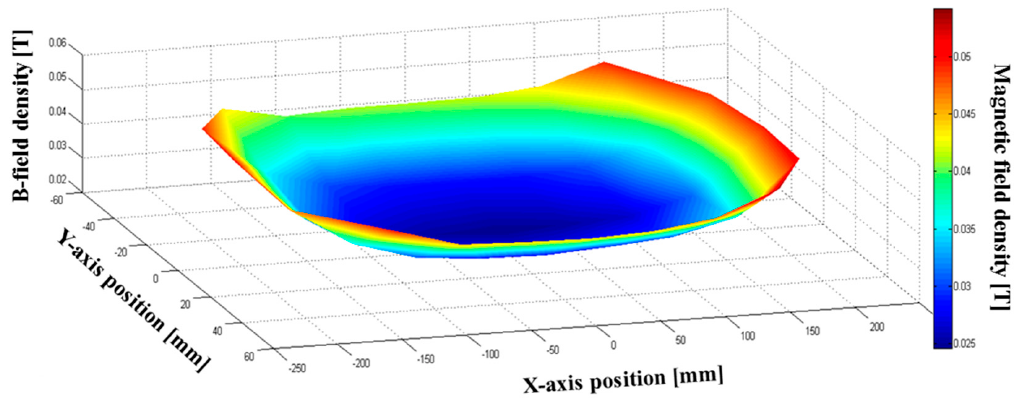
Figure 8. Measured magnetic field distribution of the fabricated NI HTS field coil.